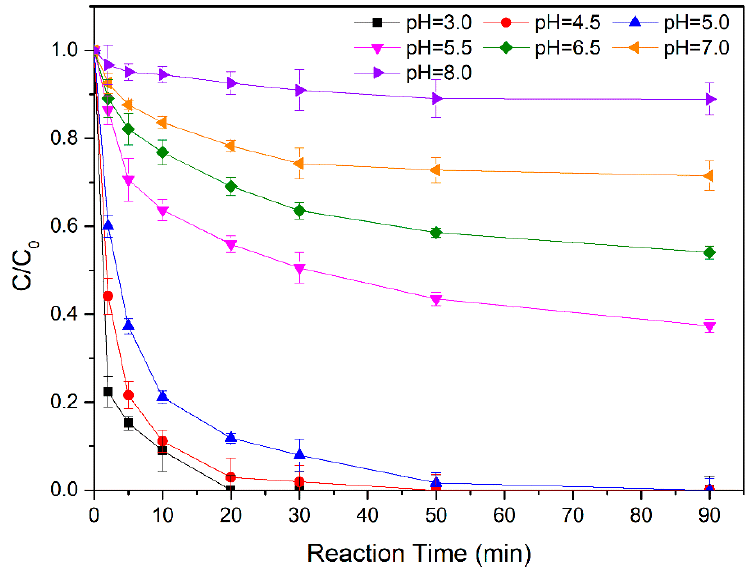
Figure 3. Effect of pH on 2,4-dichlorophenoxyacetic acid (2,4-D) degradation ([2,4-D] 0 = 5.0